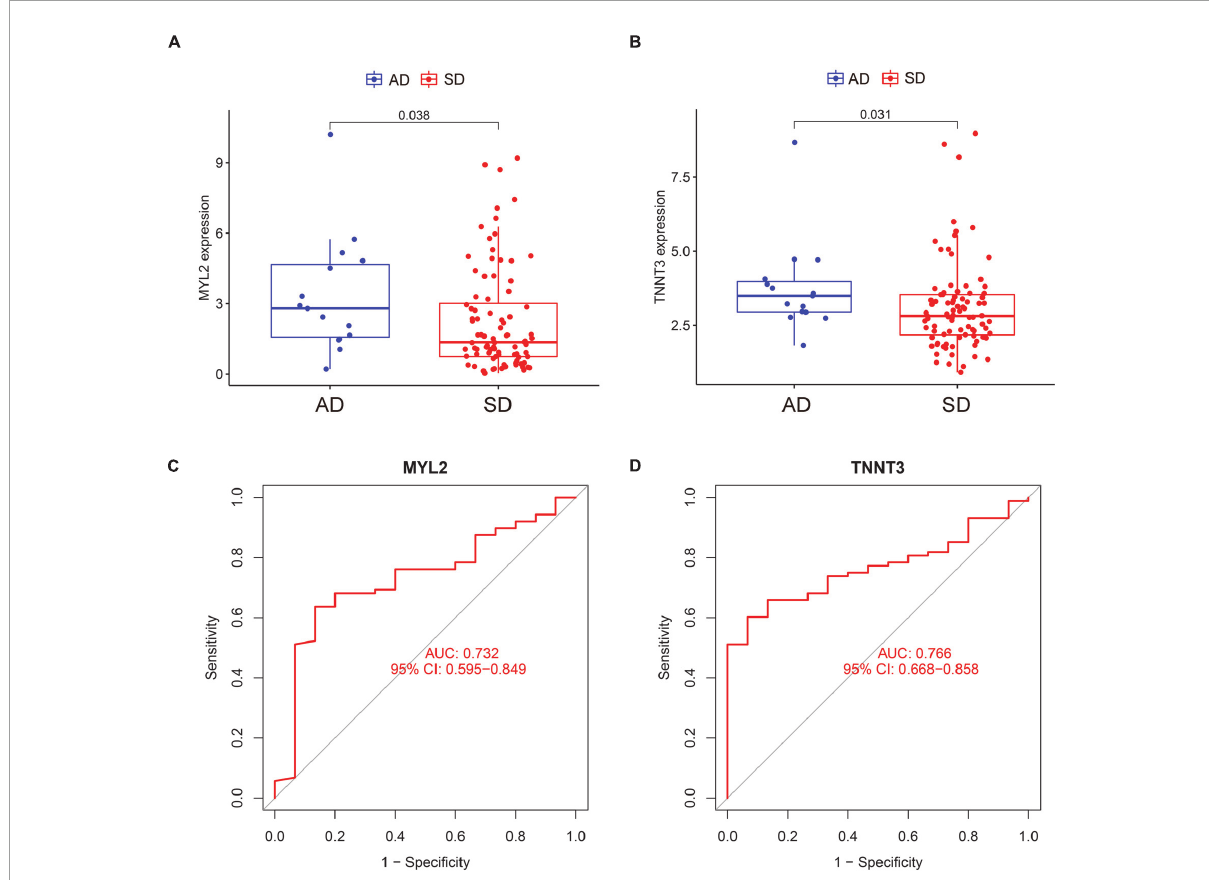
FIGURE4 Expression and ROC curves of characteristic genes of sudden death. (A) The expression level of MYL2 in AD and SD groups. (B) The expression level of TNNT3 in AD and SD groups. (C) The ROC curve of MYL2. (D) The ROC curve of TNNT3. ROC, receiver operating characteristic; AD, Accidental death; SD, Sudden